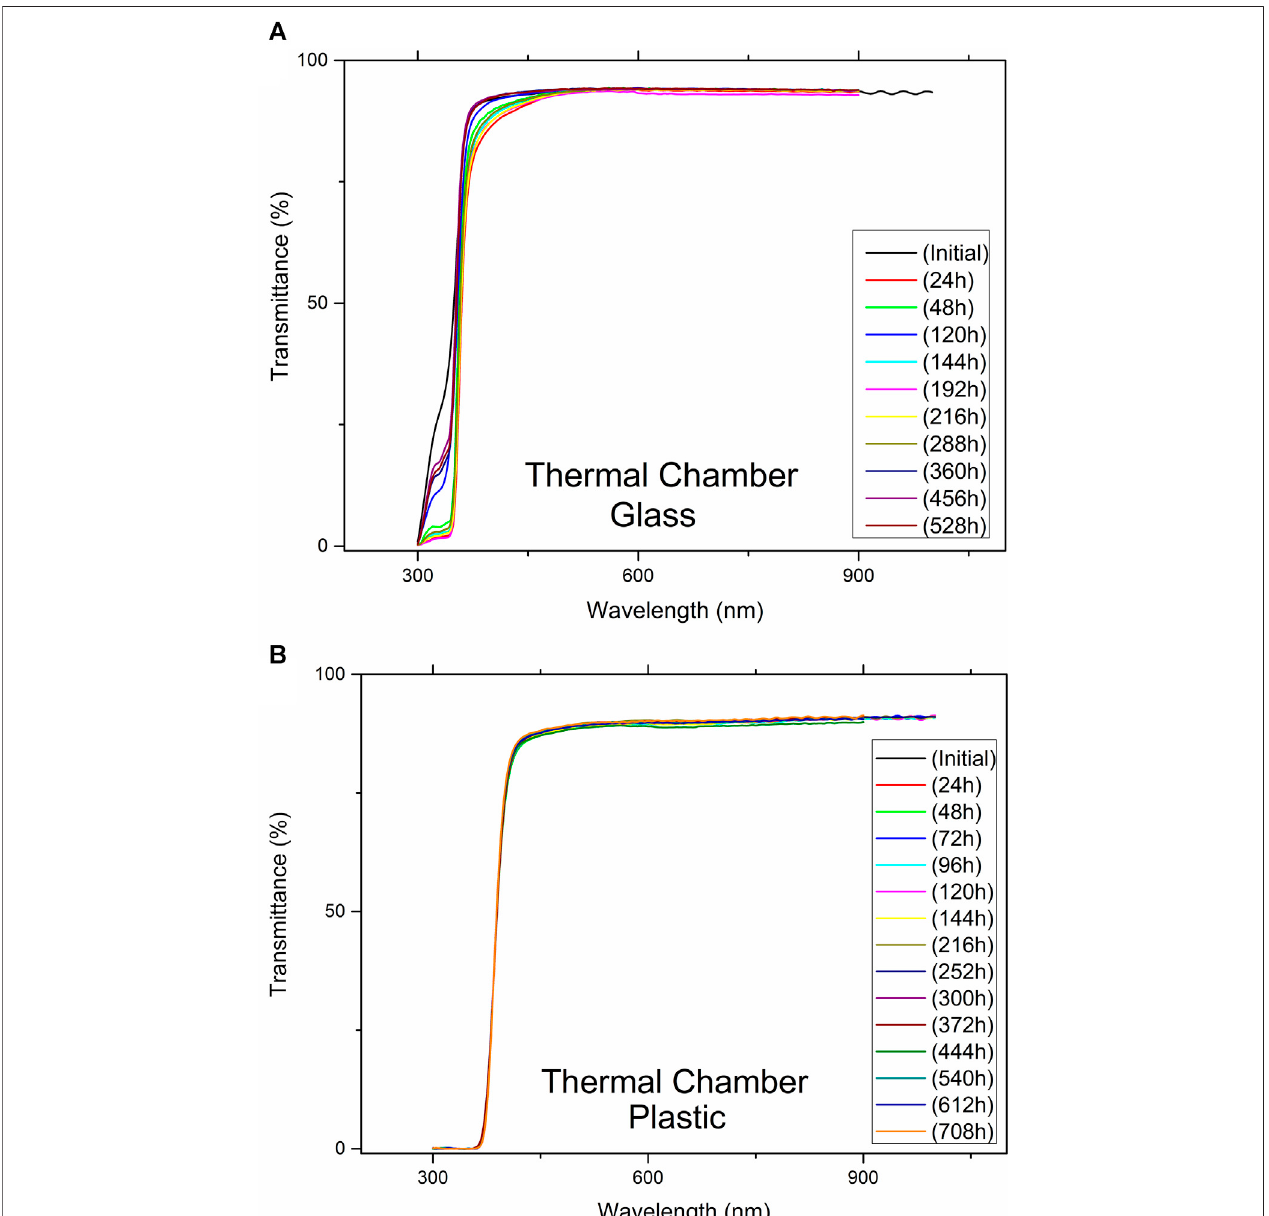
FIGURE 9 | Evolution of the transmittance vs. time for ISOS-T-3 for both encapsulations (glass (A) and plastic (B) , respectively).